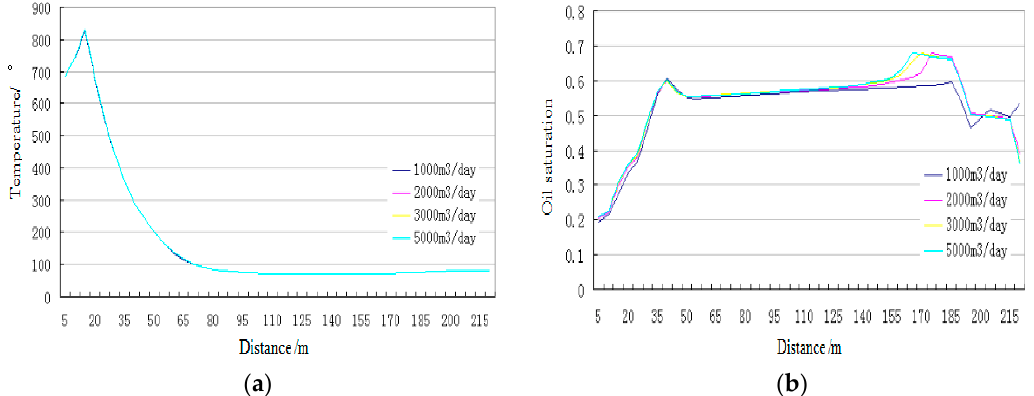
Figure 5. The temperature change of the firing front and oil saturation change under different air injection speeds. ( a ) temperature change of the firing front; ( b ) oil saturation change.